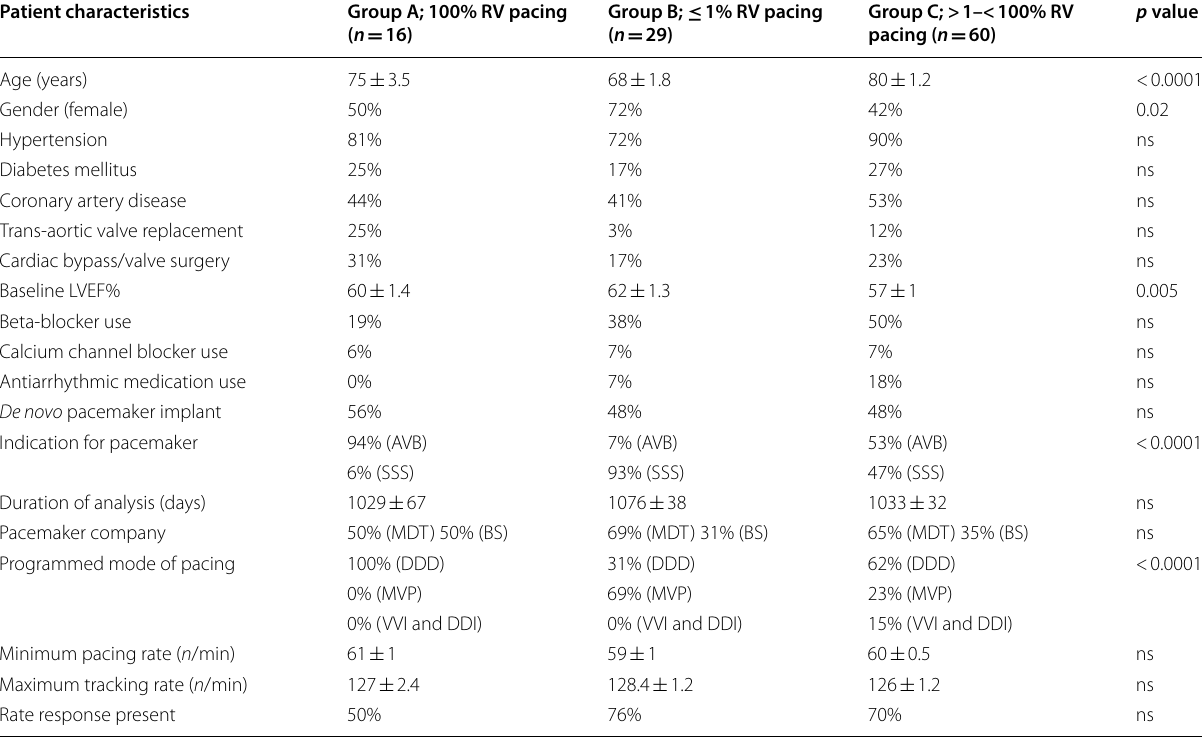
LVEF, left ventricular ejection fraction; AVB, atrioventricular block; SSS, sick sinus syndrome; MDT, Medtronic; BS, Boston scientific; DDD, dual paced, dual sensed, dual inhibited/triggered; MVP, managed ventricular pacing; RV, right ventricular; ns, not significant. ANOVA for continuous variables; chi‑square test for categorical variables